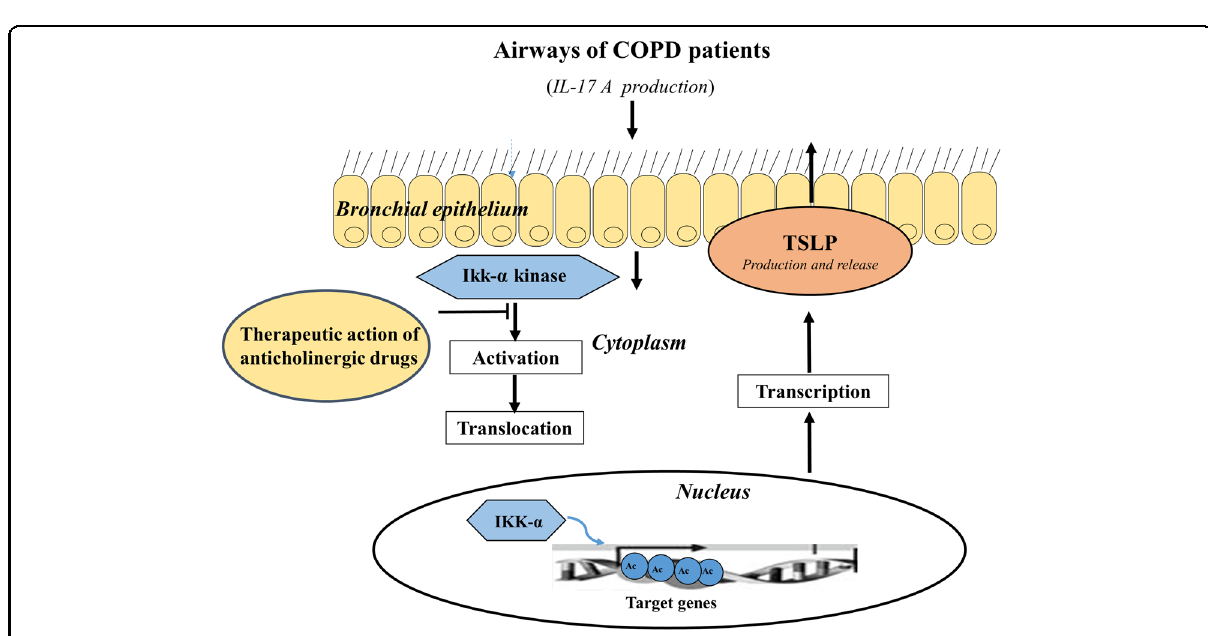
Fig. 7 Graphical abstract. Summary of the